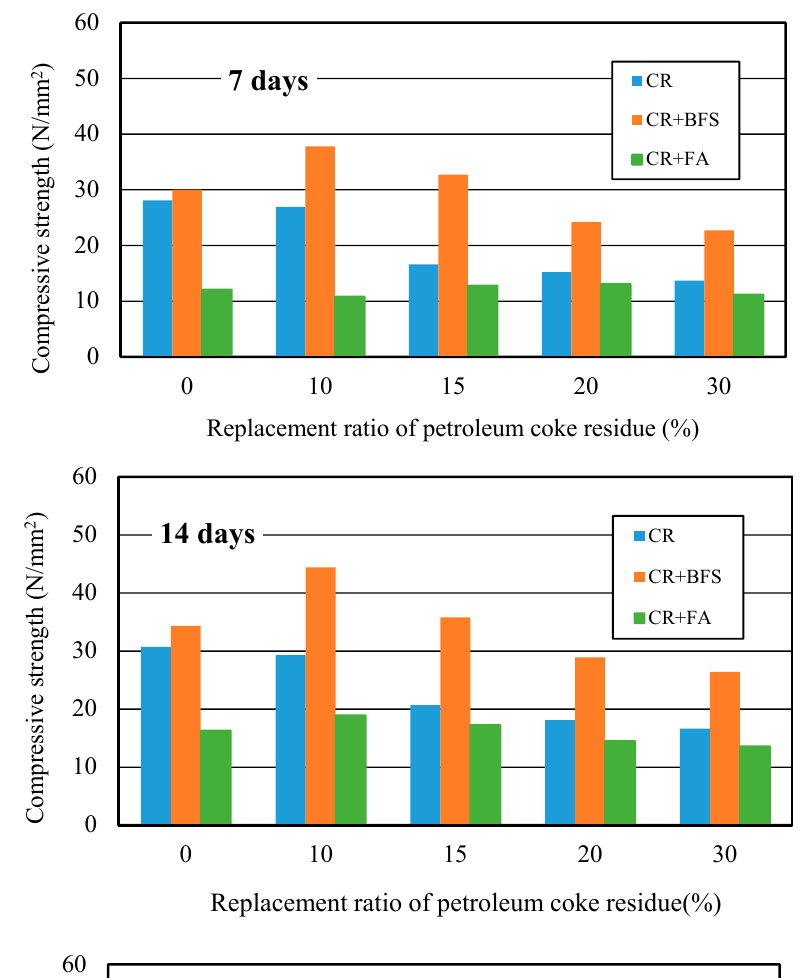
13 of 18 Figure 13. Cl − penetration coefficient of coke residue concrete with different replacement ratios. 3.4. The optimum Proportion of Multi-Added Petroleum Coke Residue with Mineral Admixture in Concrete 3.4.1. Compressive Strength Development Figure 14 showed the strength development of three kinds of concrete at different curing days. It can be observed that the strengths of (CR+BFS) concrete at each curing age were all the highest, the strength improvement effect was more significant than single-added CR concrete, while the strength improvement effect of (CR + FA) concrete was the worst. Compared with ordinary concrete, the strength of single-added CR concrete at the replacement ratio of 10% increased by 11% at 28 days; for the (CR + BFS) concrete, when the replacement ratio of coke residue was 0% (50% cement and 50% slag), the strength of concrete reached the same level as ordinary concrete at each age; the strength of multi-added (CR + BFS) concrete at the replacement ratio of coke residue of 10 and 15% at 7 days increased by about 30.4% and 11% more than that of ordinary concrete, respectively. At 28 days, when the replacement ratio of coke residue was 10 and 15%, the strengths of (CR + BFS) concrete increased by 32% and 19%, respectively. In contrast, the strength of (CR + FA) concrete at each replacement ratio was the lowest, due to the slow hydration of fly ash and the high water absorption